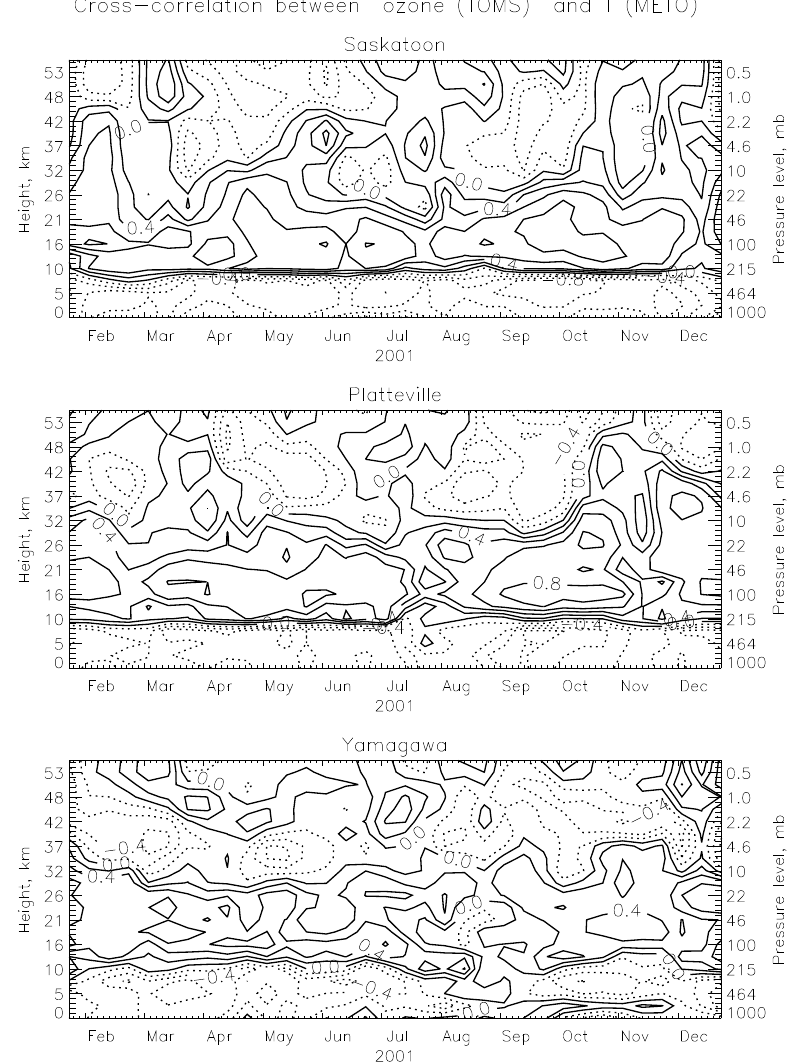
Fig. 2. The linear cross-correlation coefficients of the total ozone (TOMS) and temperature (MetO) versus time and height for three stations: Saskatoon (the top panel), Platteville (the middle panel), and Yamagawa (the bottom panel). The step between contours is